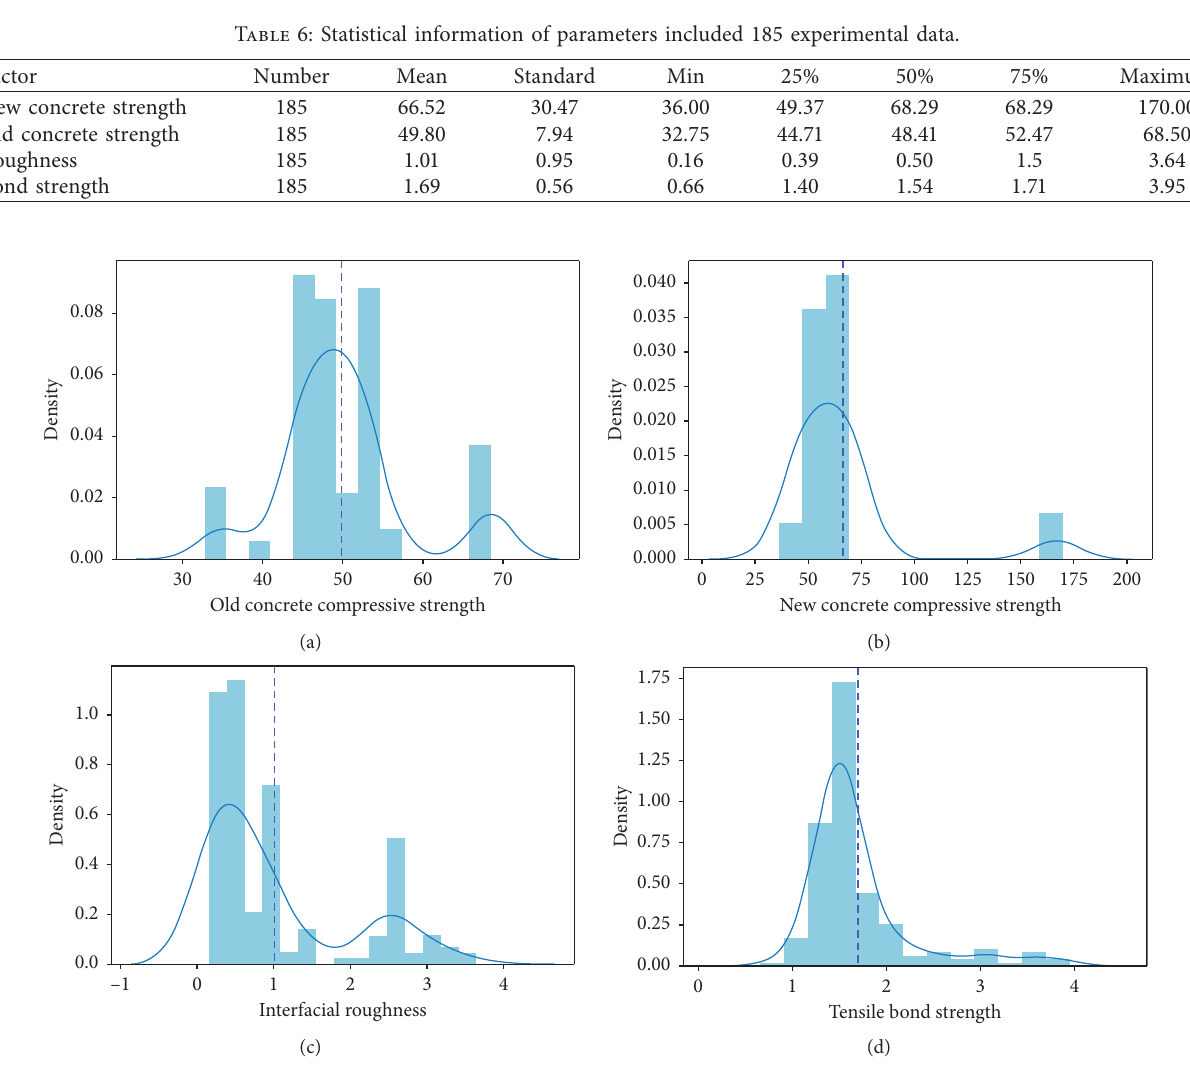
Figure 15: Statistical distributions of the experimental